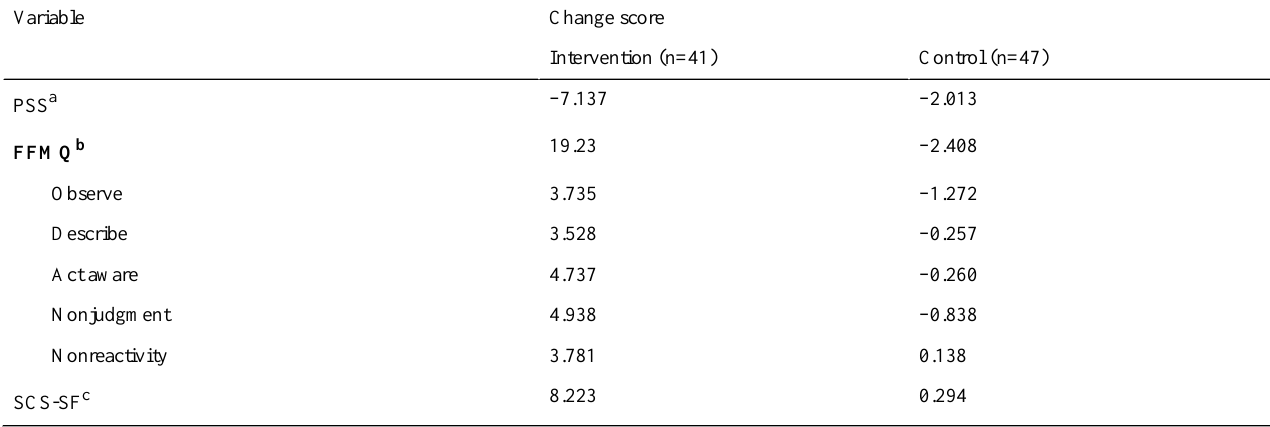
Table 3. Pre-post change scores in perceived stress, mindfulness, and self-compassion between groups (N=88; all P <.001). Scores are adjusted for age, gender, and